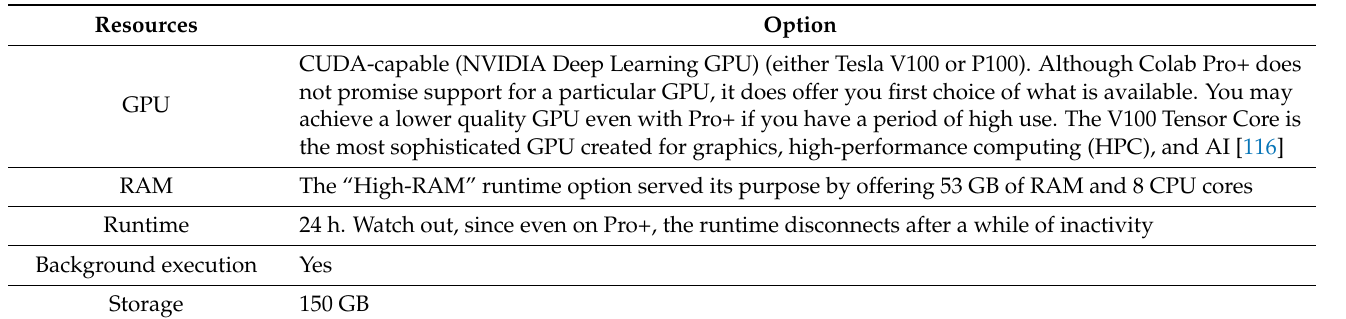
Table 6. Google Colab Pro+ resources used in this research